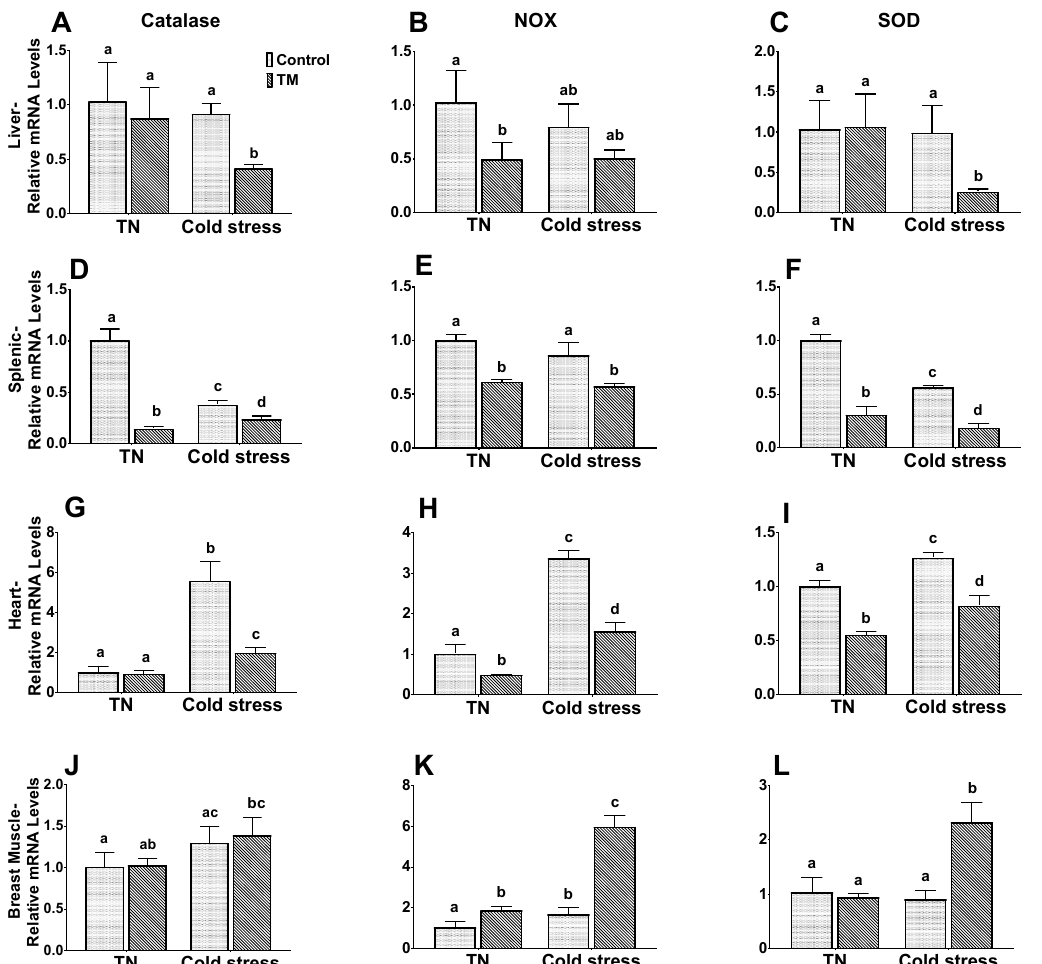
Figure 3. E ff ect of post-hatch cold stress for 5 days (PD 32 to 37) on the mRNA levels of catalase, NOX4 , and SOD2 in the liver ( A – C ), spleen ( D – F ), heart ( G – I ), and breast muscle ( J – L ) in TM broiler chickens (n = 5). a–d means ± SD with non-identical superscripts are significantly di ff erent. Catalase . TM did not significantly change the cardiac, hepatic, and muscular mRNA levels